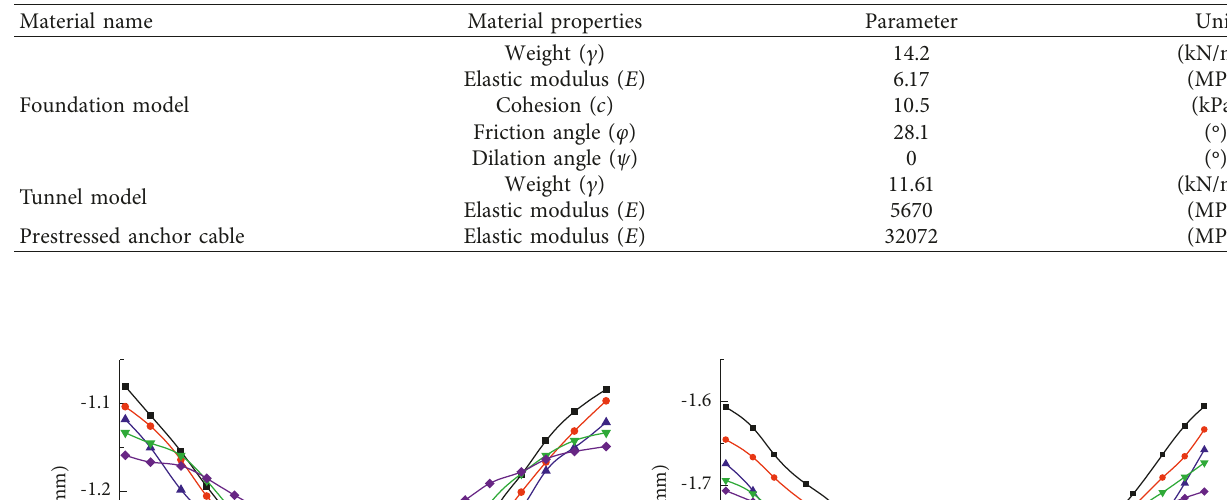
Table 4: Calculation parameters of numerical